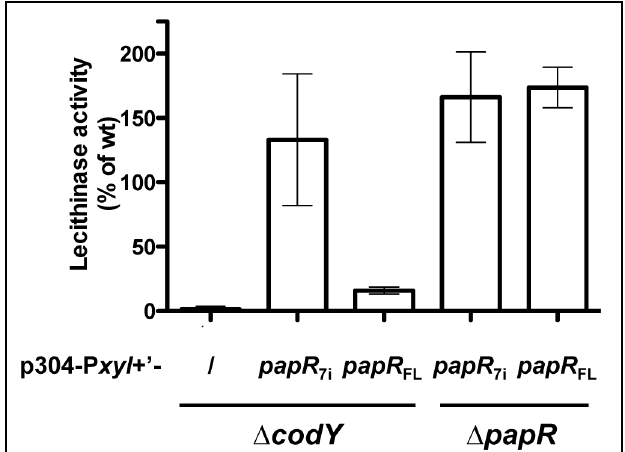
FIGURE 3 | Lecithinase production in Bt (cid:2) codY compared to the wild-type strain when the mature form of PapR is produced inside the cells. (cid:2) codY and (cid:2) papR cells harbor the p304-P xyl + ’ vector carrying a transcriptional fusion between the xylose-inducible promoter P xylA and either papR 7 i , coding for the mature form of PapR (7 aa), or papR FL , coding for full length PapR (including the signal sequence). / indicates that the cells are devoid of these plasmids. Filter-sterilized supernatants from samples harvested 1 h after entry into stationary phase were assayed for lecithinase production. The results are the mean values of two independent experiments, and the error bars represent standard deviation.